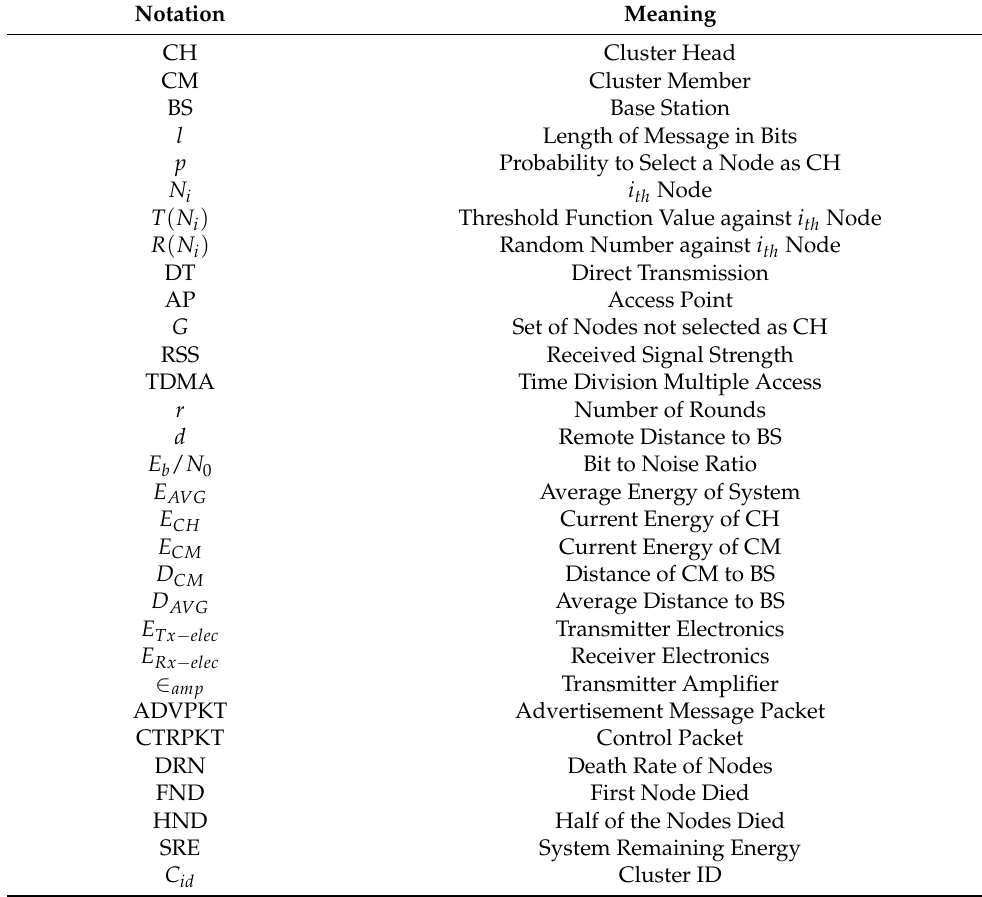
Table 1. Summary of the used